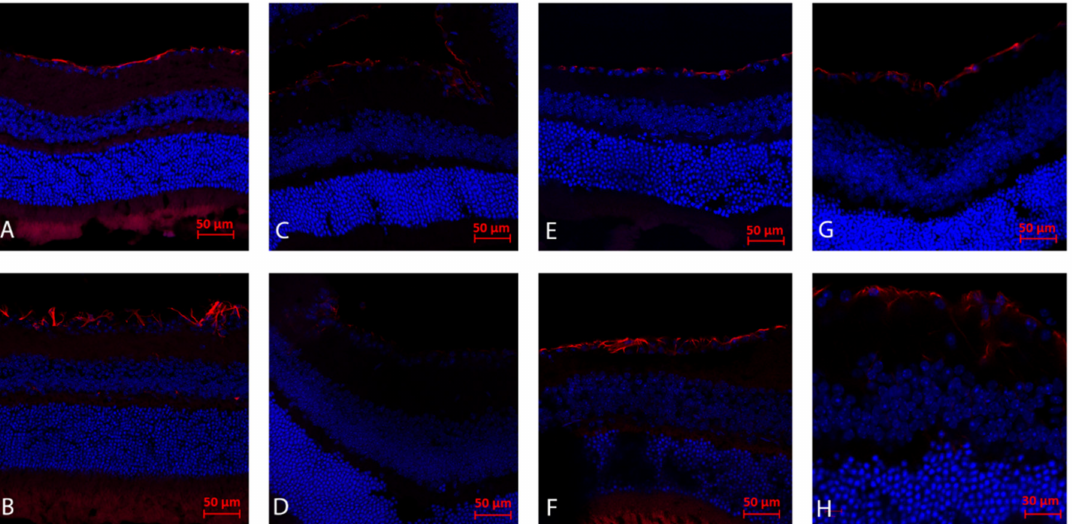
Figure 1. Immunohistochemistry analysis (day 21): Gliosis (GFAP). ( A ) The right eye of WT mouse following ONC and injected with AZ, demonstrating reduced gliosis and RGC preserva- tion in comparison to right eye ONC without AZ treatment ( B ). The left eye of a WT mouse with AZ ( C ) as compared to the control left eye without AZ, ( D ) both demonstrating minimal gliosis. NSG mice following right eye ONC and systemic AZ injection demonstrates right moderate gliosis and RGC preservation, ( E ) as compared to right eye following ONC without AZ ( F ). Note that NSG mice following ONC demonstrate reduced gliosis both with ( E ) and without ( F ) AZ injection as compared to WT mice following ONC with AZ injection ( A ). NSG mice left control eye with ( G ) and without ( H ) AZ systemic